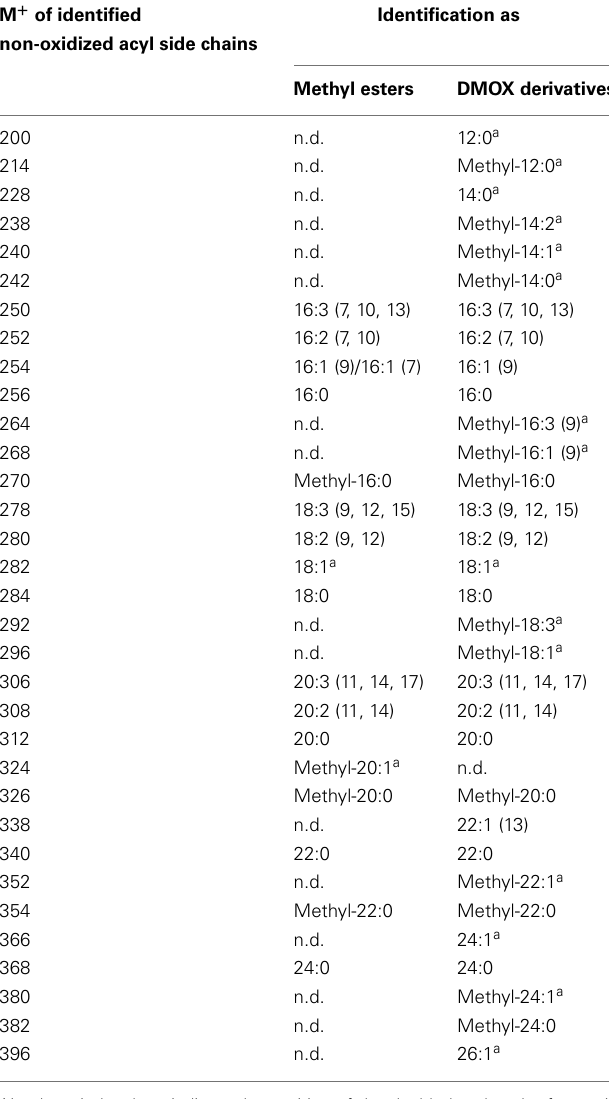
Table 4 | Straight- and branched-chain fatty acids identified as methyl esters as well as DMOX derivatives by GC/MS.